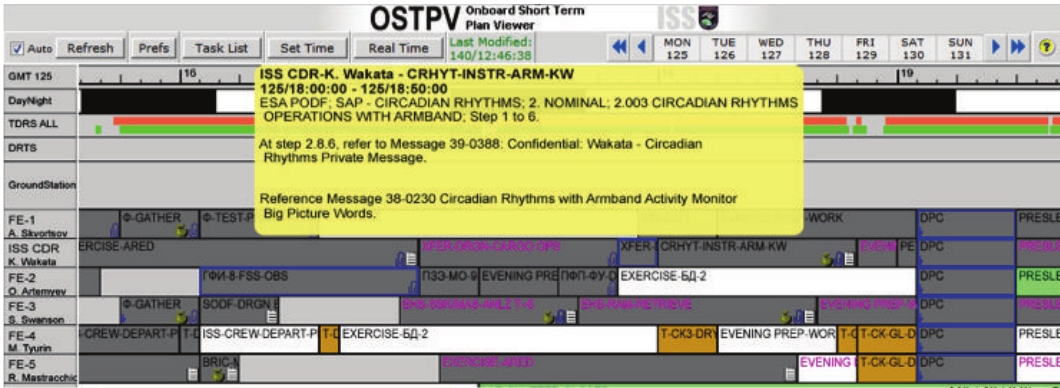
Figure 3: Example of on-board timeline with Execution Note details for an arbitrary activity called up (yellow box).